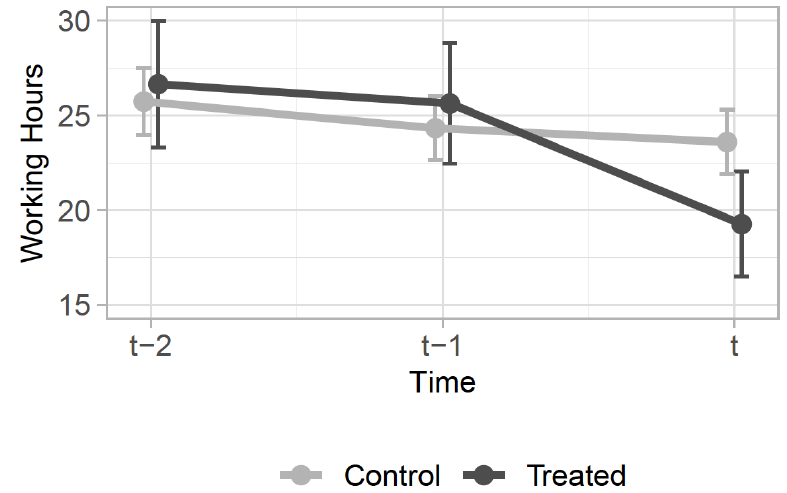
Figure 1: Assessment of Common Trend in Positive